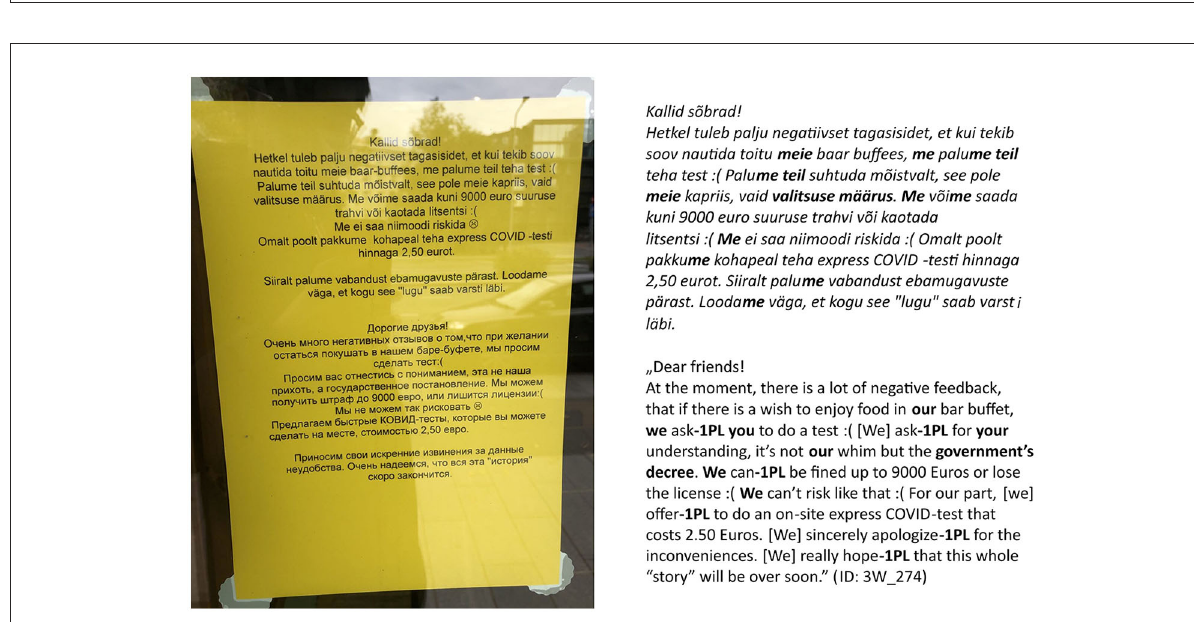
FIGURE12 Type of person usage “both 1st and 2nd person” (expressions_of_authority_YES + imperative_NO).